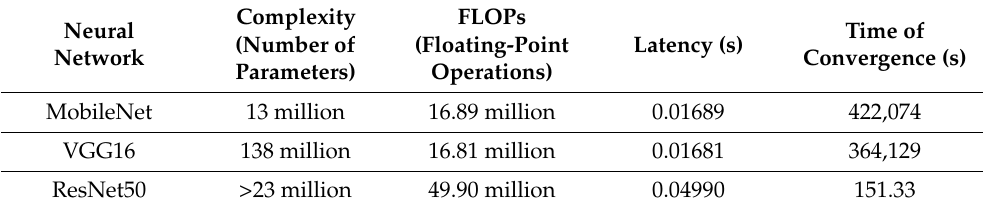
Table 6. Neural network metrics